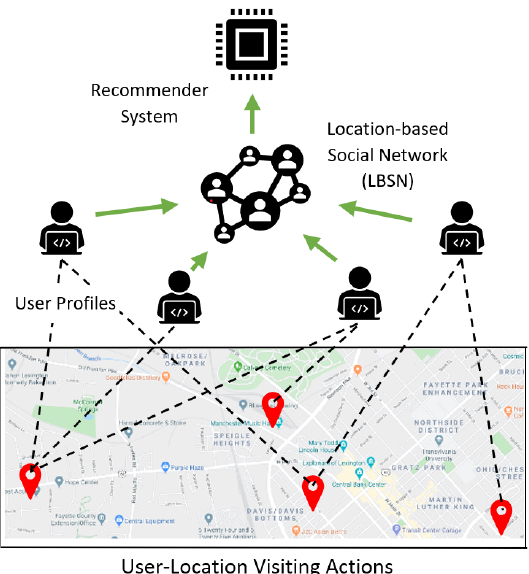
Figure 1. The framework of a traditional centralized POI recommender system above an LBSN. The users’ private information is collected by location-based social networks and aggregated in the central